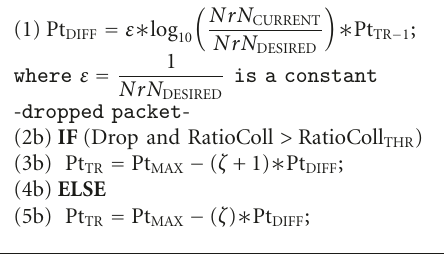
Algorithm 3: Enhanced power